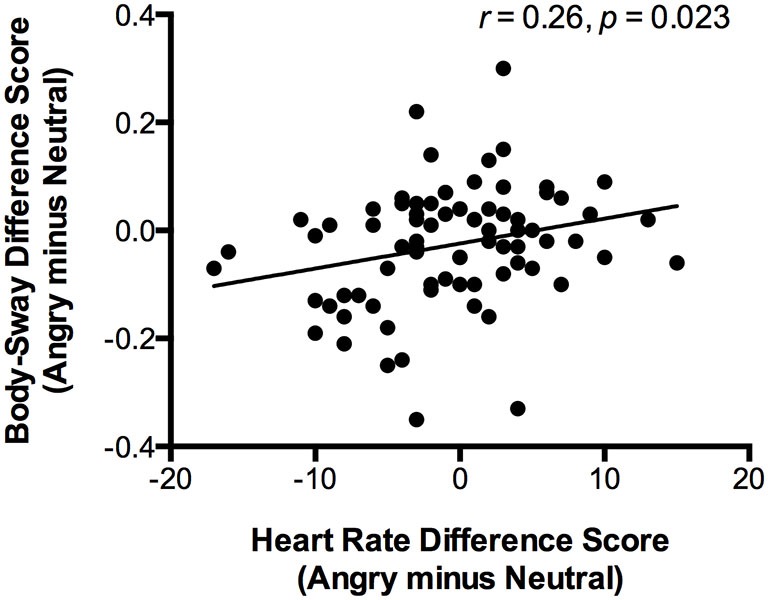
The scatter plot (with best-fitting regression line) illustrates the correlation between change in heart rate variability (in beats per minute) and change in body-sway variability (in mm) while participants viewed angry compared to neutral faces. Change in heart rate variability was calculated by subtracting heart rate of the neutral-faces block from the same measure of the angry-faces block. The same calculation was applied to conduct body-sway variability.